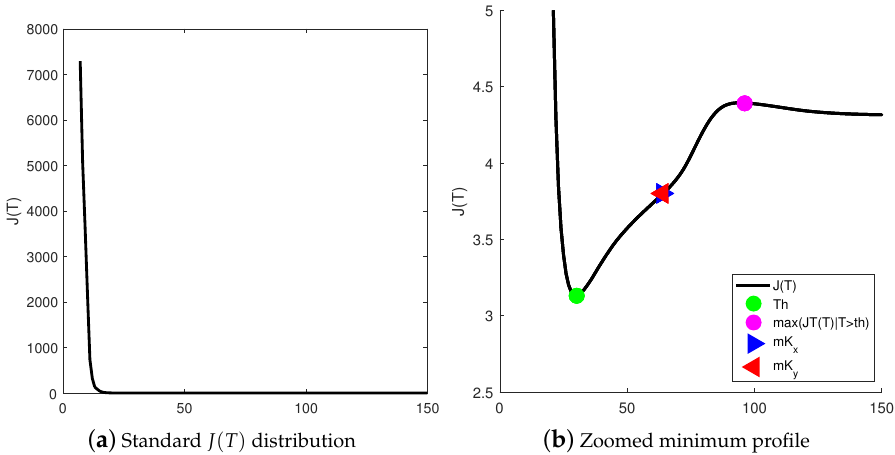
Figure 6. Kittler error function J ( T ) .